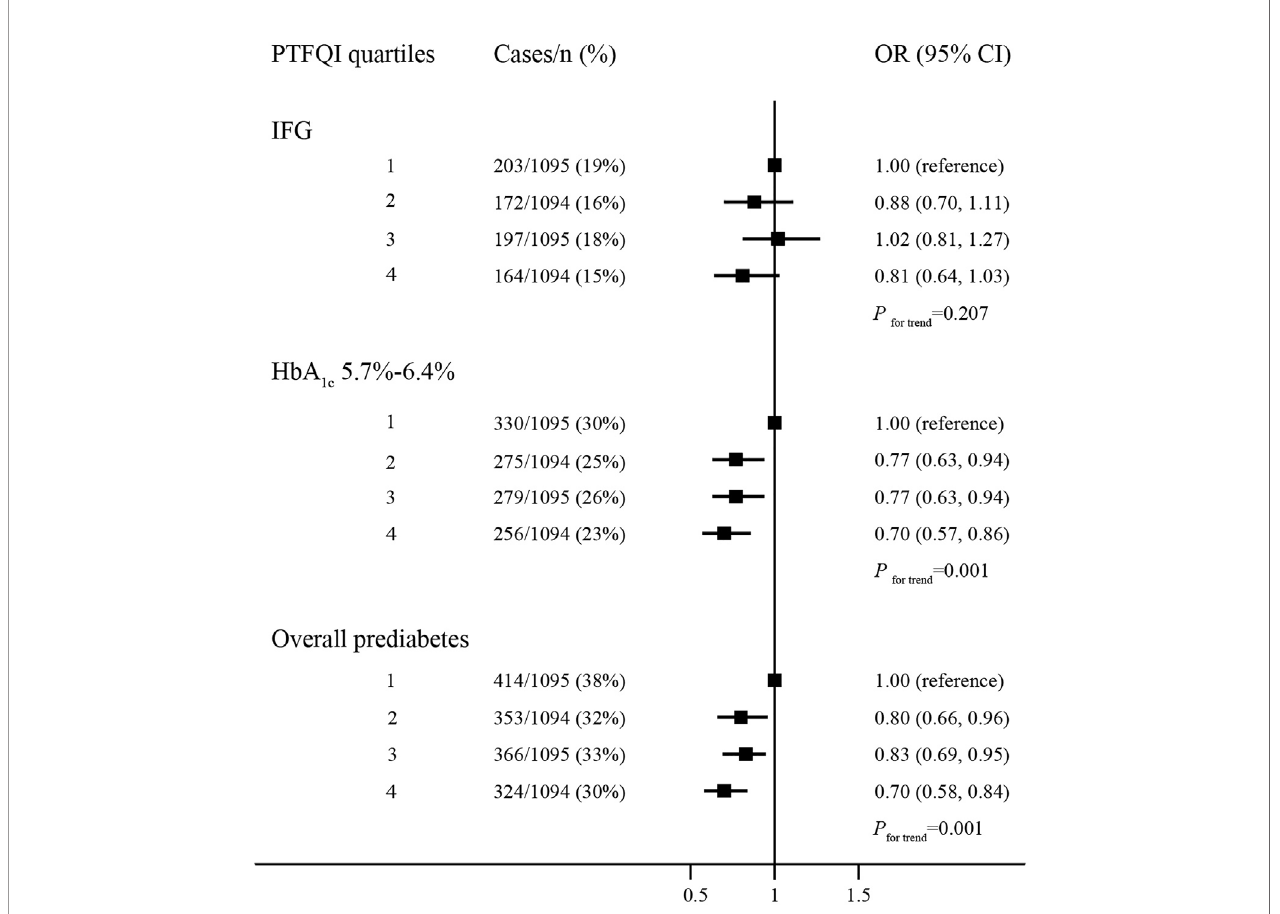
FIGURE 1 | The association between quartiles of PTFQI and risk or prediabetes. Logistic regression model; models are adjusted for age, gender, BMI, WC, hypertension and